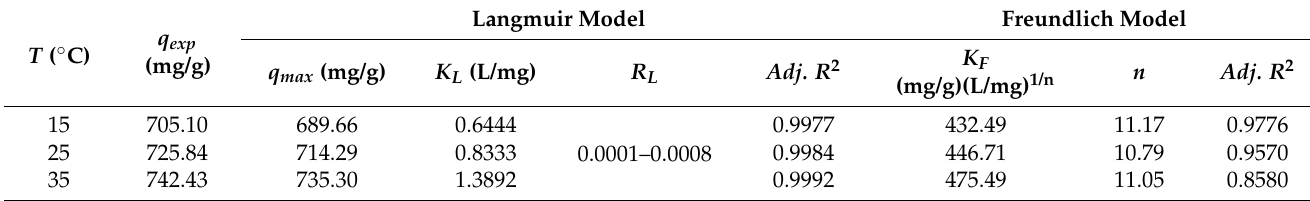
Table 4. Comparison of the adsorption capacities of functionalized MWCNTs for anionic dyes.